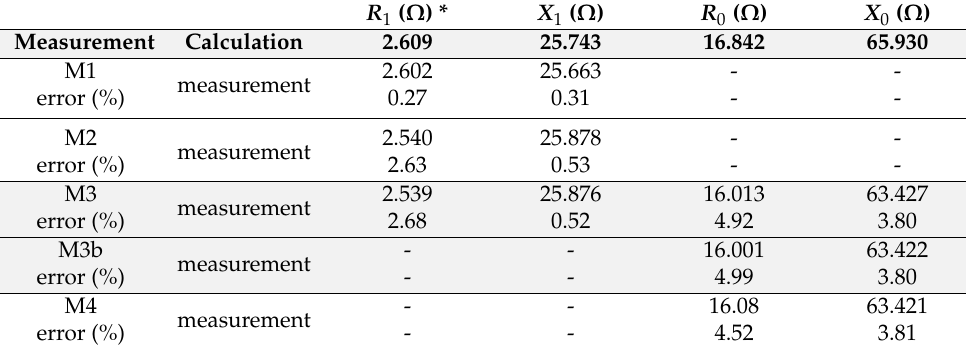
Table 6. Comparison of measurement results of investigated power